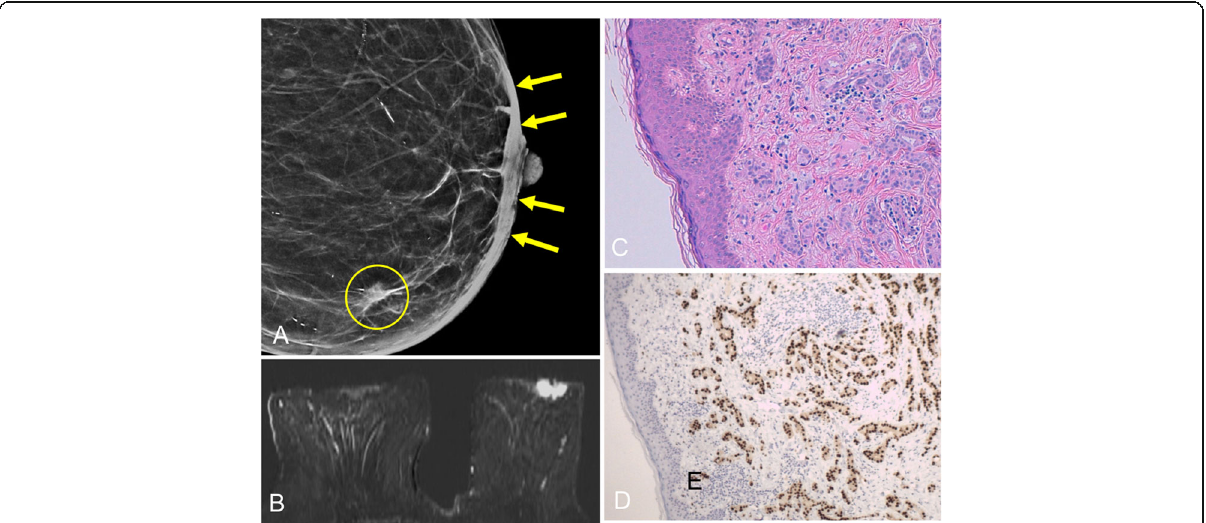
Fig. 35 Invasive ductal carcinoma (I). An 88-year-old woman with a palpable nodule in the lower inner quadrant of her left breast. a Synthesized 2D mammogram shows a spiculated nodule (circle), classified as infiltrating lobular carcinoma at histology. Note the thickening of the skin and of the nipple-areolar complex (arrows). b MRI shows pathologic asymmetric enhancement of the left nipple-areolar complex. c Hematoxylin-eosin stain of punch-biopsy specimen (× 10) shows extensive dermal infiltration by infiltrating ductal carcinoma. d Immunohistochemistry (× 4) shows diffuse nuclear expression of estrogen receptors. These are two synchronous tumors